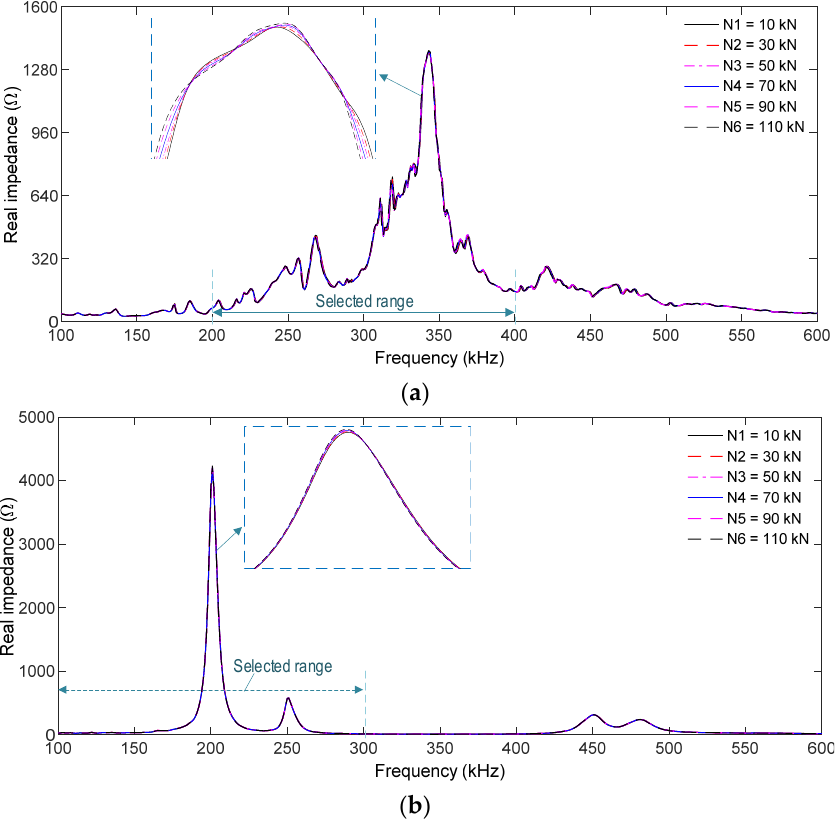
Figure 10. Numerical impedance responses of PZT sensors in the concrete sample under compression: ( a ) PZT-embedded smart rebar (SR); ( b ) PZT-embedded smart aggregate (SA).